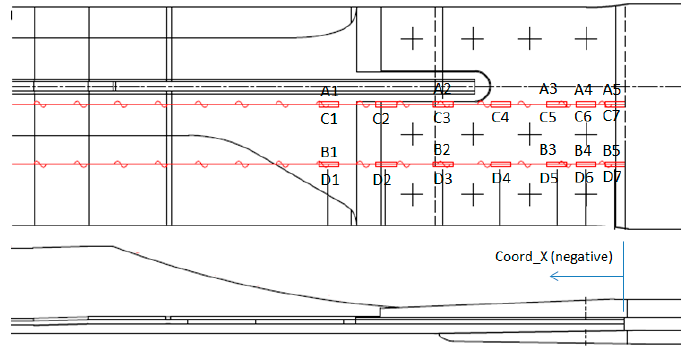
Figure 21. OF Sensor Location.